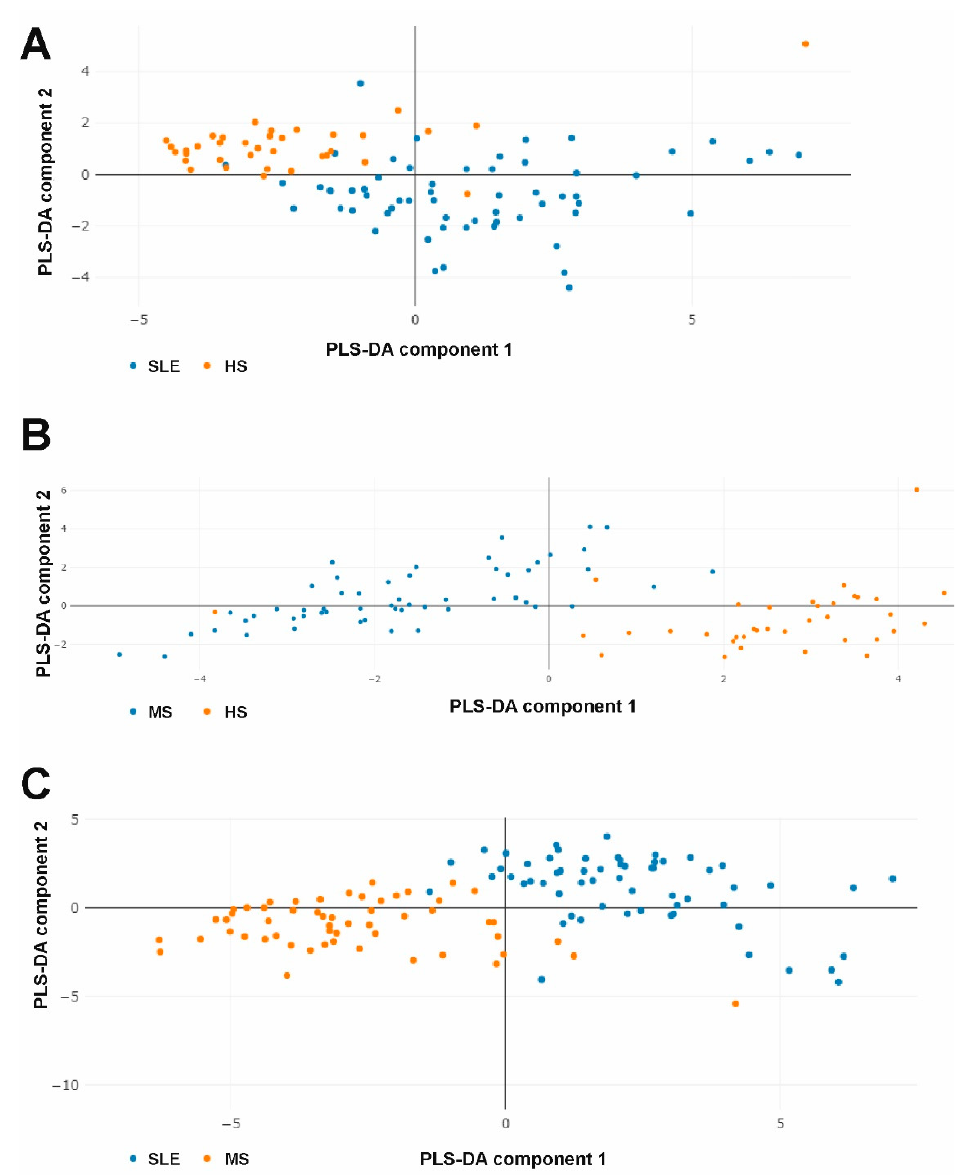
Figure 5. PLS-DA plots of combined multicytokine profiles when comparing SLE vs. HS ( A ), MS vs. HS ( B ), and SLE vs. MS ( C )